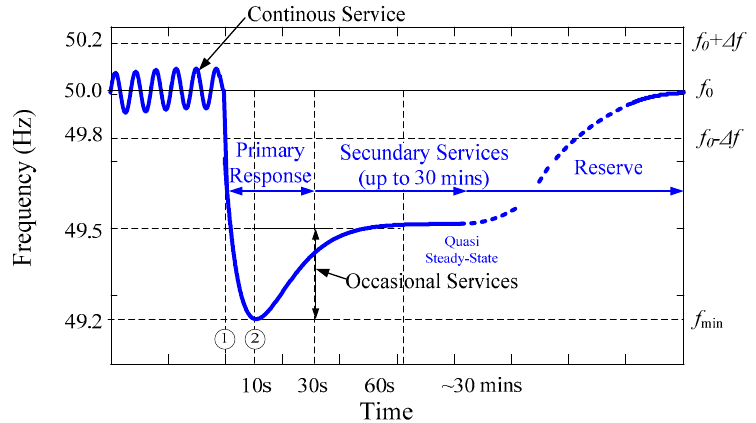
Figure 1. Illustrative example of the system frequency response for an under-frequency event indi- cating time scales of the controllers. The numerical values are shown as references, and they are taken from the GB frequency control system.